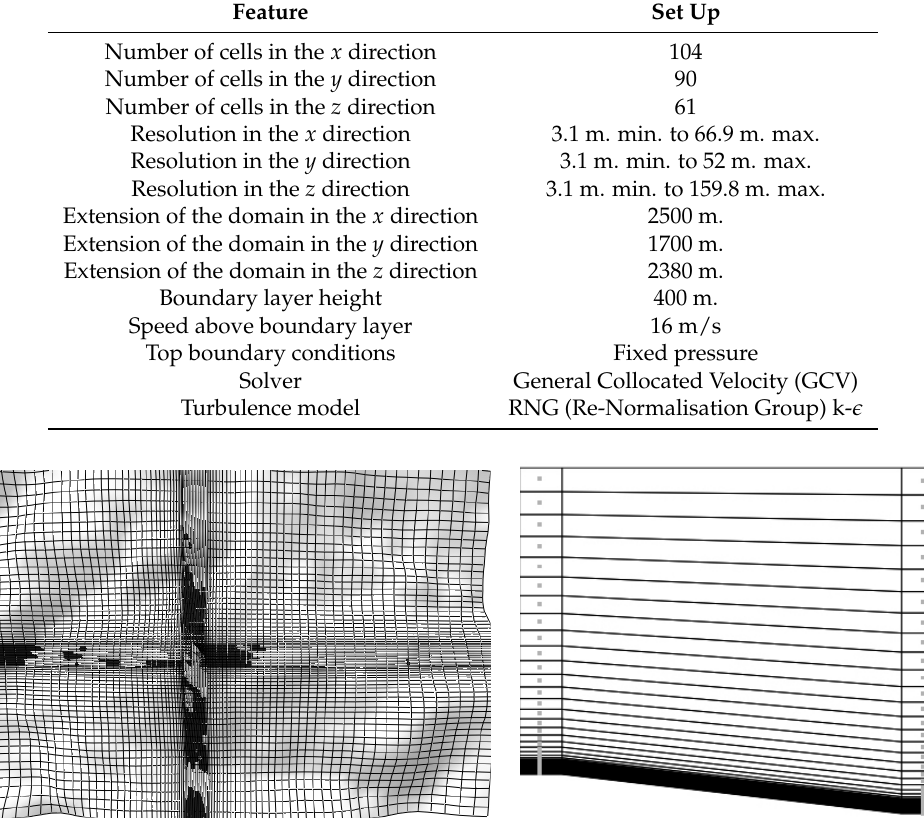
Figure 4. The horizontal (left) and vertical (right) distribution of the computational grid with the refinement around the turbine area and near the terrain